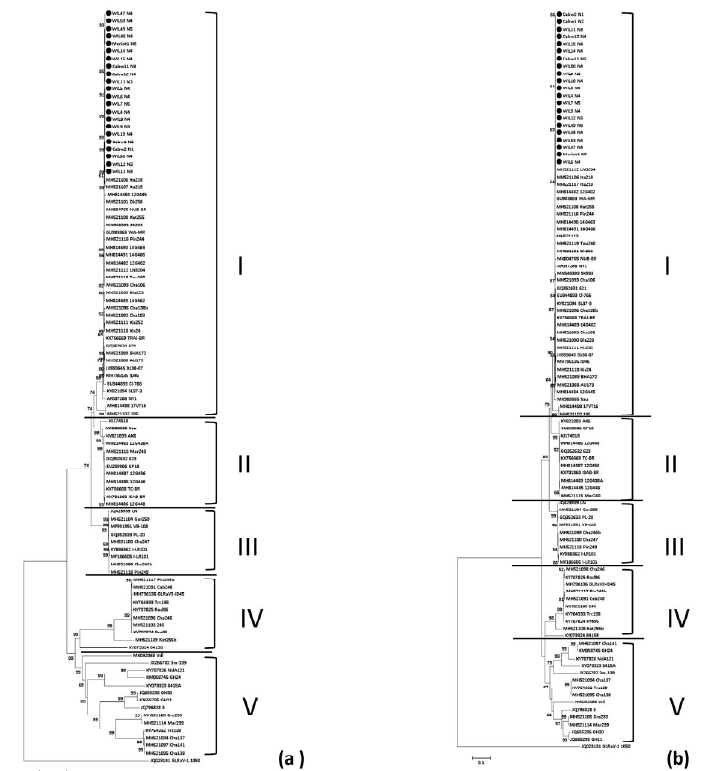
Figure 4. Phylogenetic analysis of 21 near-complete genome sequences (above 17,027 nts) of Aus- tralian grapevine leafroll-associated virus 3 (GLRaV-3) isolates and 77 publicly available full genome GLRaV-3 sequences from GenBank. A neighbour-joining tree of ( a ) complete genome sequences, ( b ) nucleotide sequence of the coat protein gene, was constructed with 1000 bootstrap replicates by MEGA software. Black dots denote sequences generated by Meta ‐ HTS of this study. The bootstrap values below 50% are not shown. Sequences generated by this study are labelled by black dots. Roman numerals I–V represent the five distinct GLRaV ‐ 3 phylogroups observed in this study.